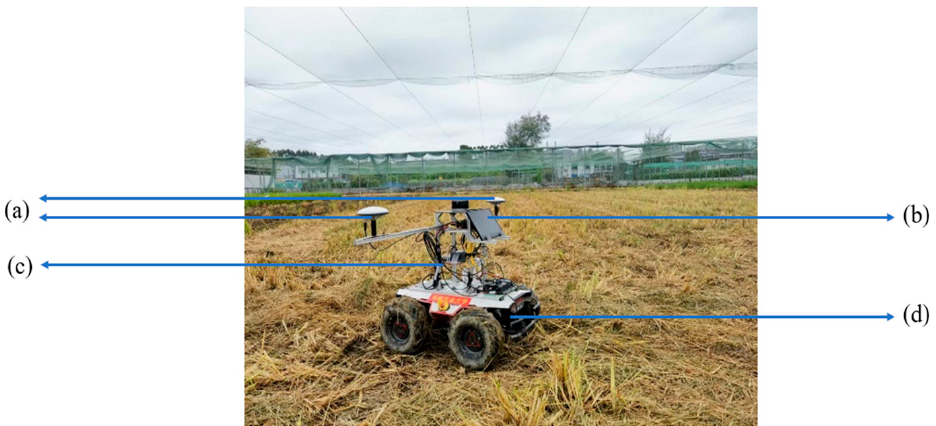
Figure 11. Actual picture of the seeding robot. (a) denotes the dual-antenna GNSS; (b) indicates the industrial computer screen; (c) indicates the industrial computer; and (d) indicates the robot chassis.